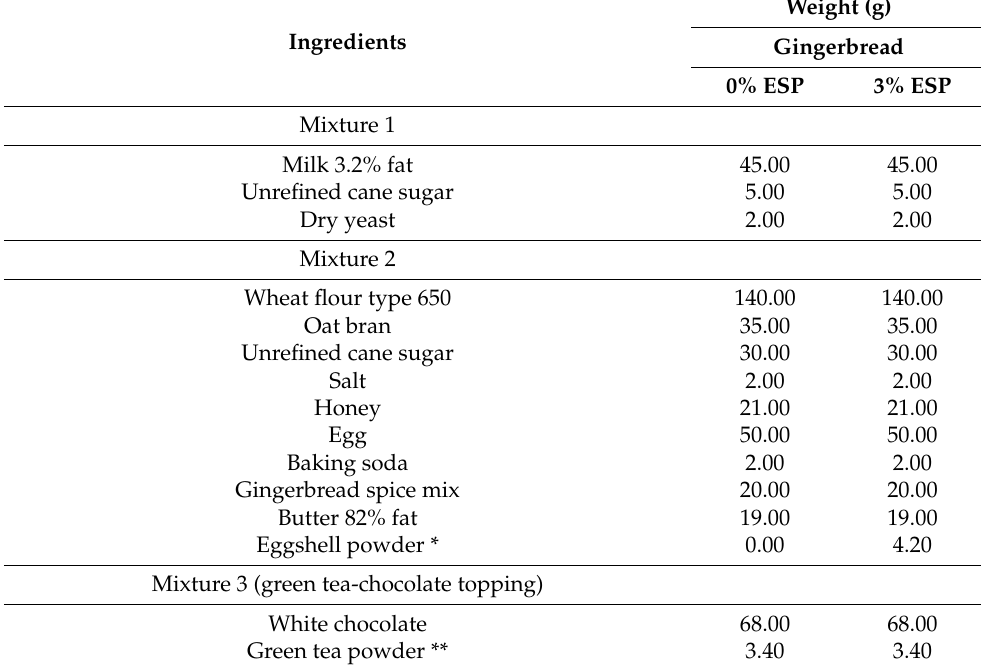
Table 1. Formulation of